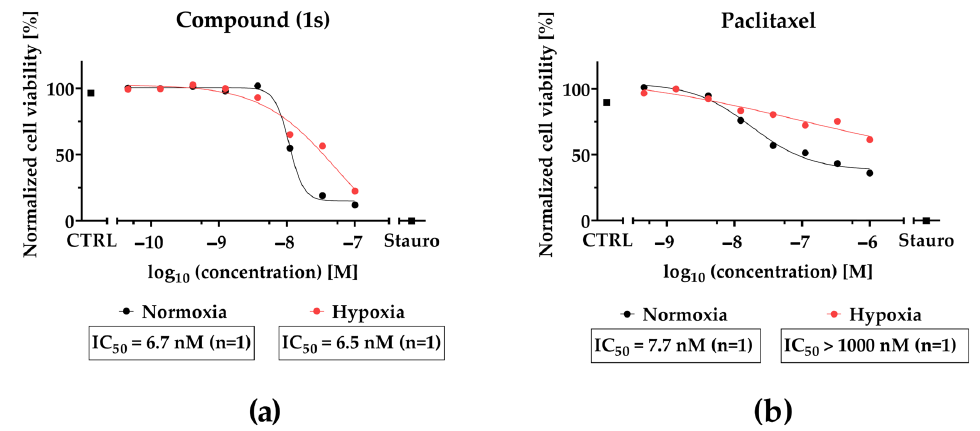
Figure 10. CoCl 2 -simulated hypoxia affects the inhibition of cell viability of paclitaxel but not O -methyltylophorinidine ( 1s ) in MDA-MB-468-UnaG. For HIF-1 α -stabilization, cells were grown for 24 h in the presence of 100 µ M CoCl2 (hypoxia) or left unstimulated (normoxia). Compound treatment was done ( a ) for ( 1s ) in a three-fold serial dilution starting at 100 nM and ( b ) for paclitaxel at a three-fold serial dilution starting at 1000 nM. Untreated (CTRL) and 10 µ M staurosporine (Stauro) treated groups served as control. Cell viability was determined as relative fluorescence unit and was normalized in each individual experiment to the lowest (0%) and highest (100%) value (normalized cell viability). Data points represent one individual experiment.